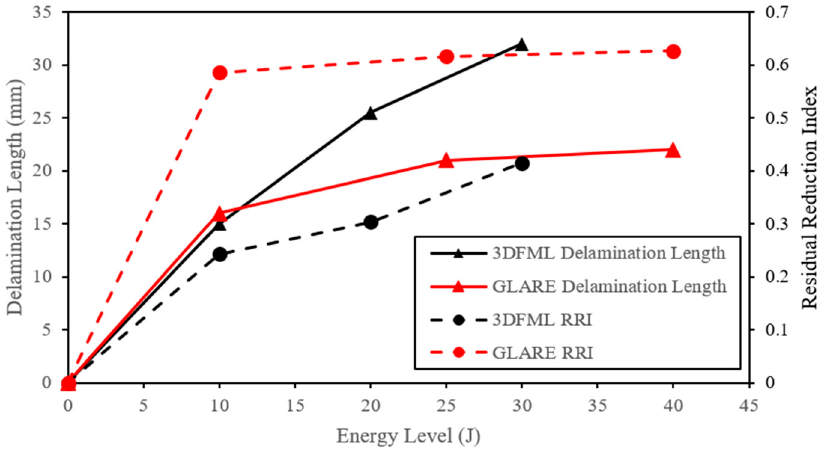
Figure 21. A comparison between delamination length and 𝑅𝑅𝐼 .